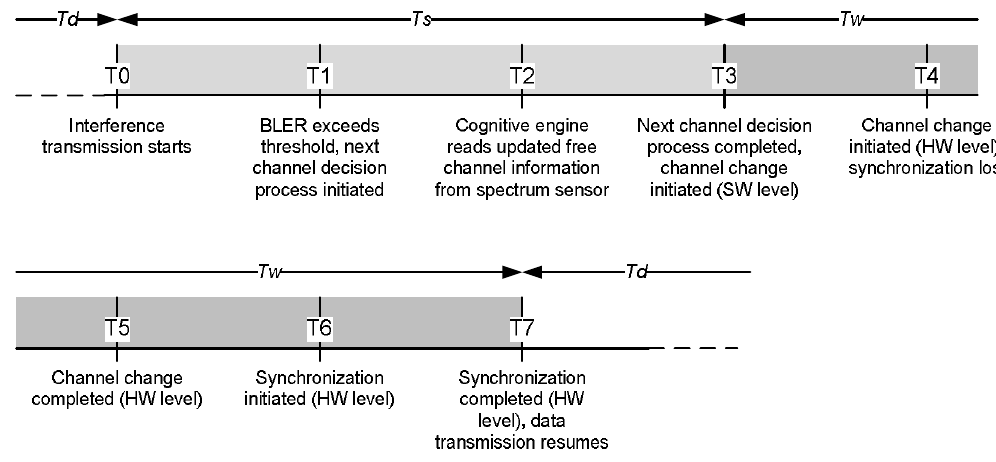
Figure 11. Details of the time domain operation during a channel